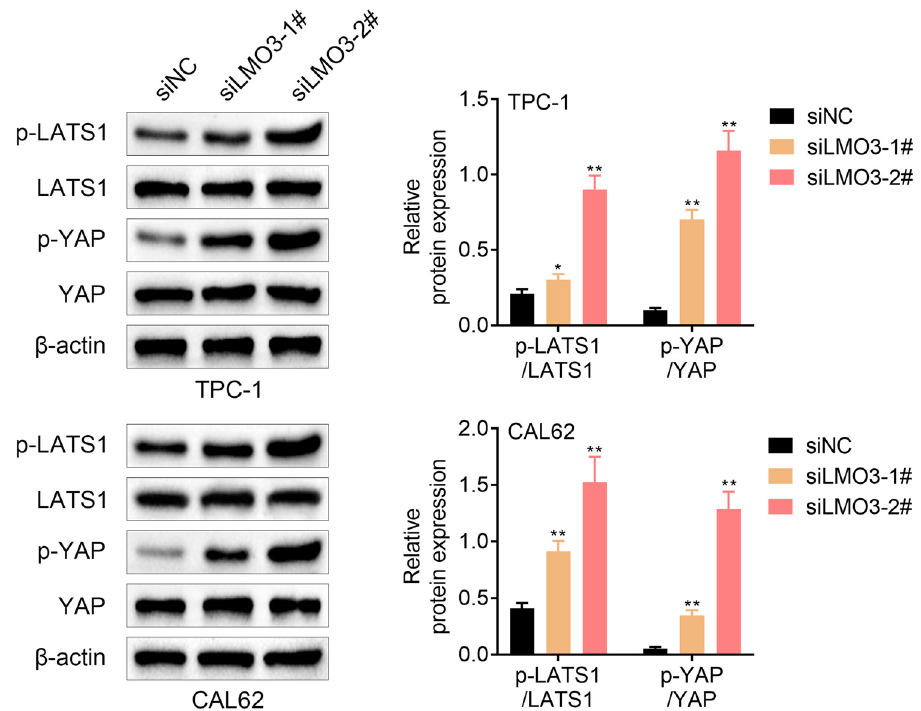
Figure A1: Knockdwon of LMO3 reduced the phosphorylation of LATS1 and YAP expression in TPC - 1 and CAL62. *, ** vs siNC, p < 0.05, p <